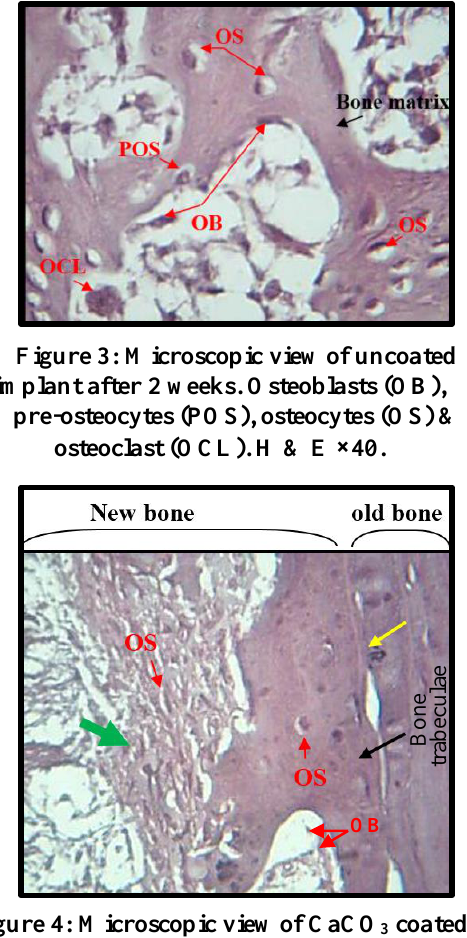
Figure 4: Microscopic view of CaCO 3 coated implant after 2 weeks shows new bone trabeculae in thread area filled with new osteocytes (OS) lined by osteoblast (OB). Reversal line (yellow arrow). Woven bone (green arrow) filled with osteocytes (OS). H & E ×40.